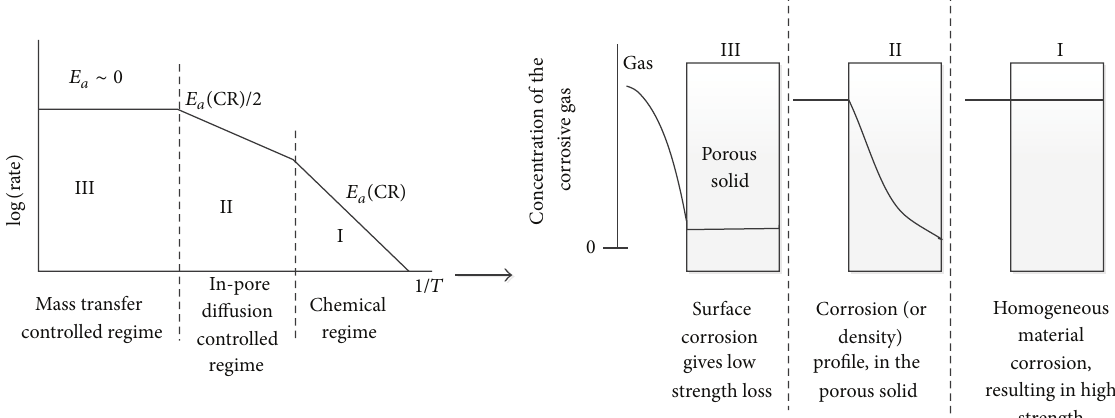
Figure 2: The schematic of oxidation of porous carbon materials by gaseous